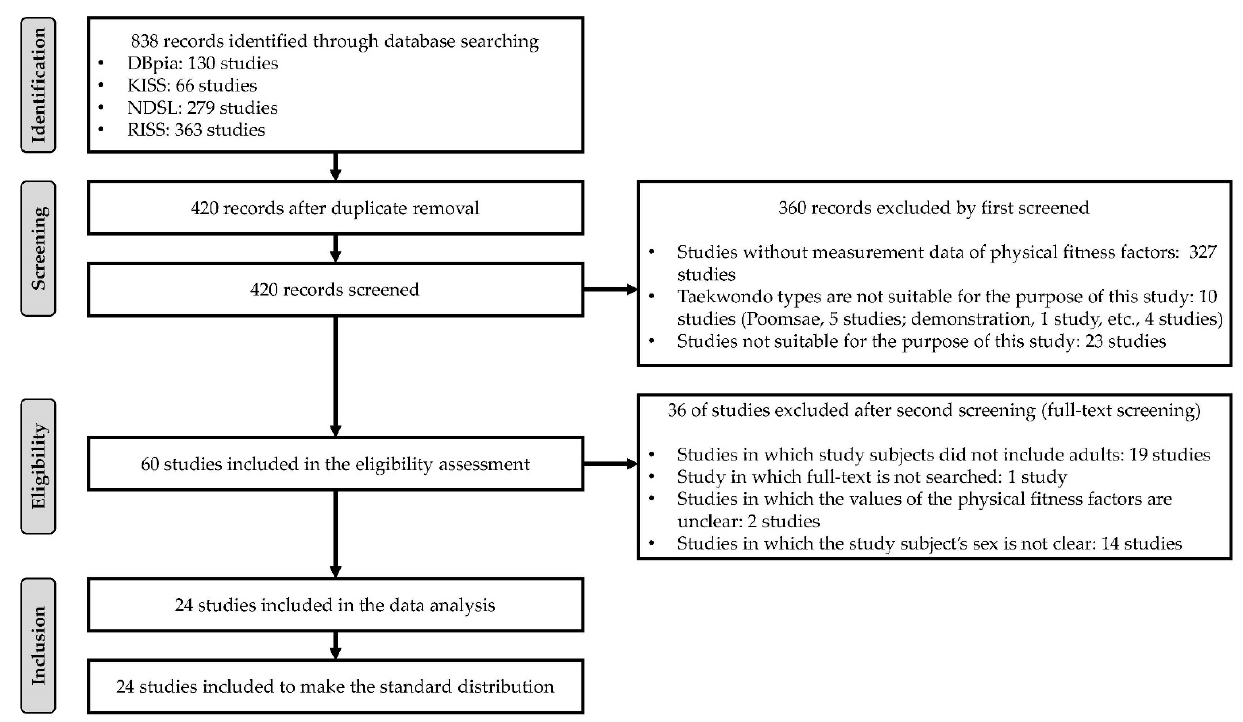
Figure 1. Flow diagram of the study screening and selection